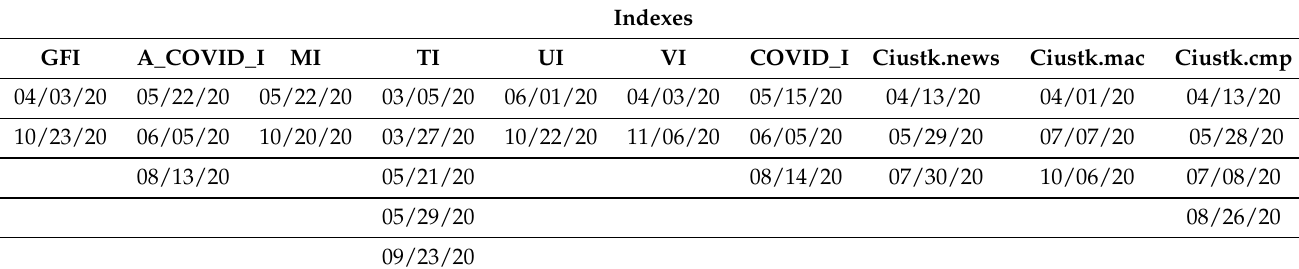
Table 2. Breaks in the variance for global